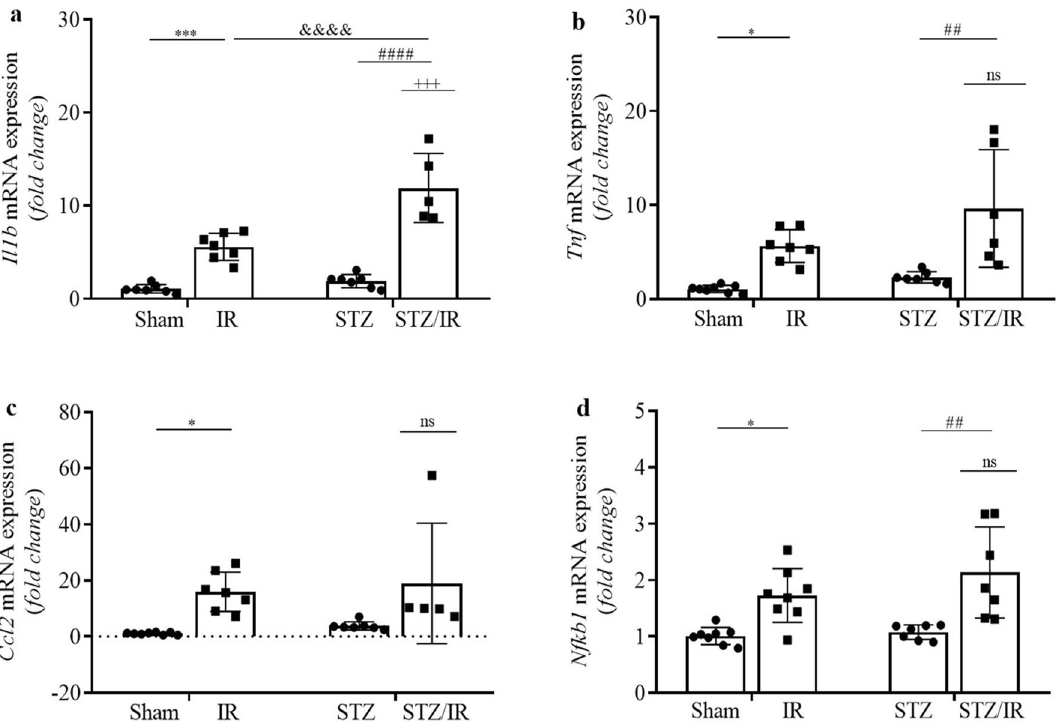
Figure 5. Effect of renal ischemia/reperfusion in vehicle- and STZ-treated mice on Il1b (IL-1β) ( a ), Tnf ( TNF- α) ( b ), Ccl2 ( MCP-1) ( c ), and Nfkb1 (NF қ B) ( d ) mRNA expression. +++ p < 0.001 for the interaction between diabetes and renal IR (STZ/IR), as indicated by two-way ANOVA (Supplementary Table S2). The Bonferroni post hoc test was also performed: *p < 0.05, ***p < 0.001 vs sham group; ## p < 0.01, #### p < 0.0001 vs STZ group; &&&& p < 0.0001 vs IR group. The values are the mean ± SD (n = 5–8). Sham sham-operated, IR ischemia/ reperfusion, STZ streptozotocin, STZ/IR streptozotocin/ischemia/reperfusion, ns